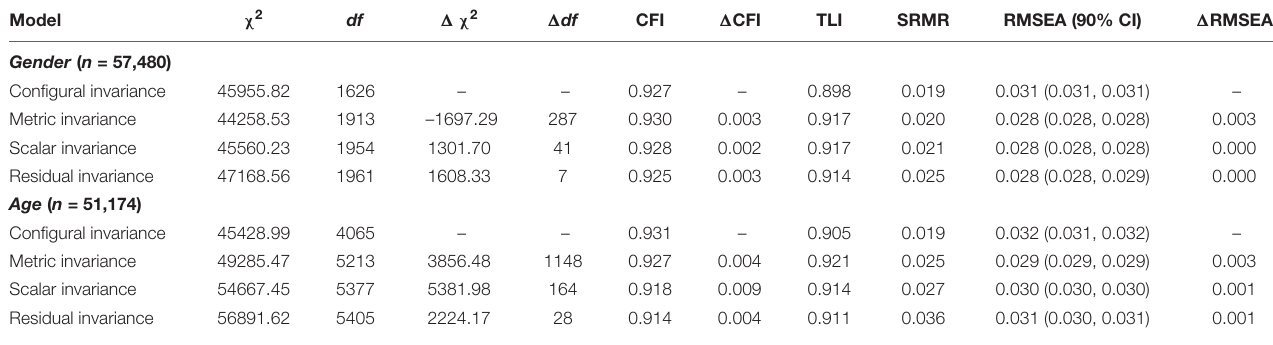
TABLE 2 | Measurement invariance testing for bifactor model by gender and age.